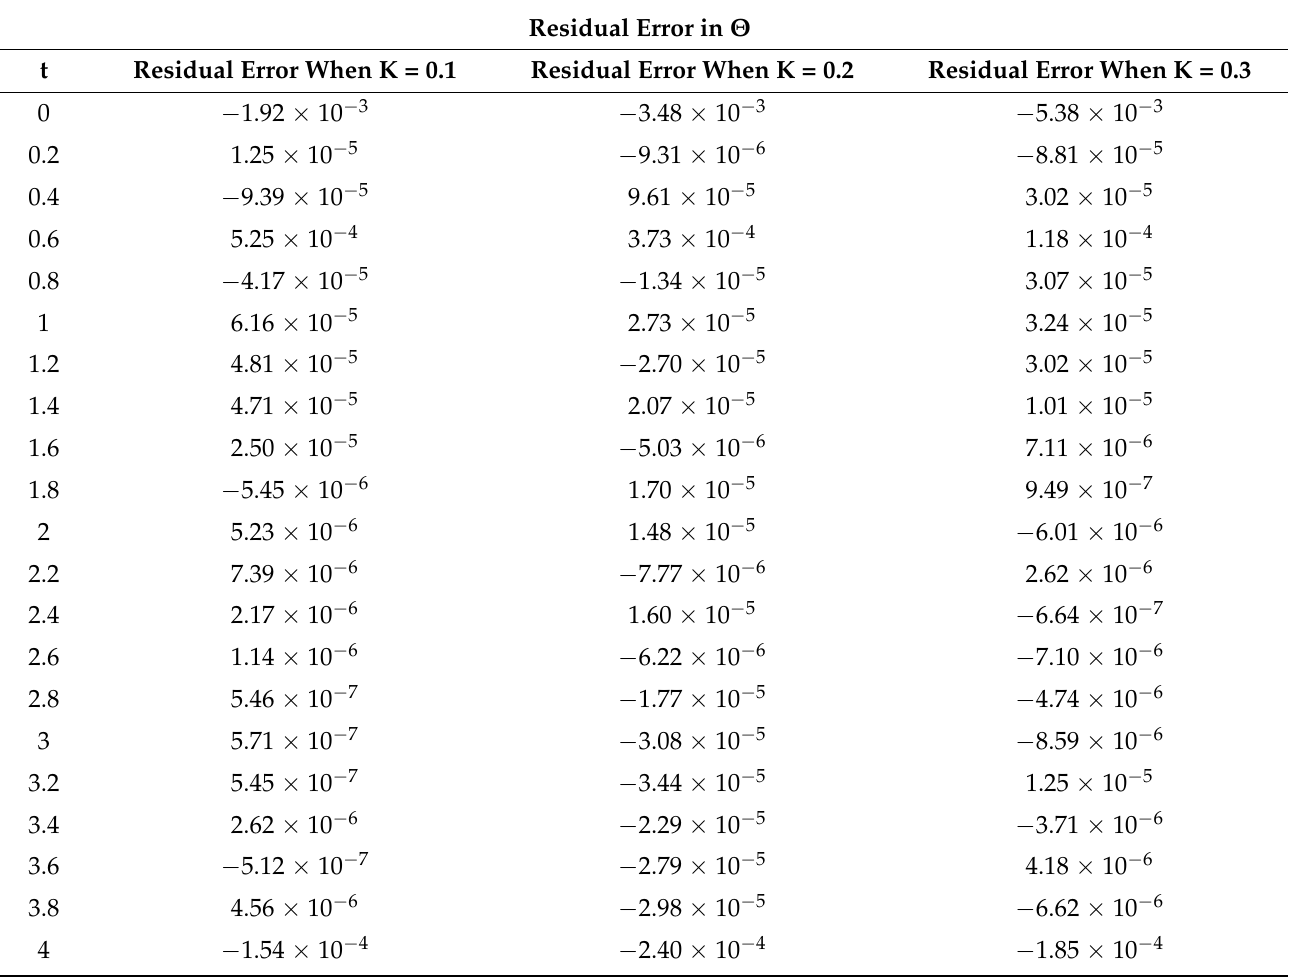
Table 9. Residual error with the reference solution of RK4 in Θ . These residual errors are obtained from